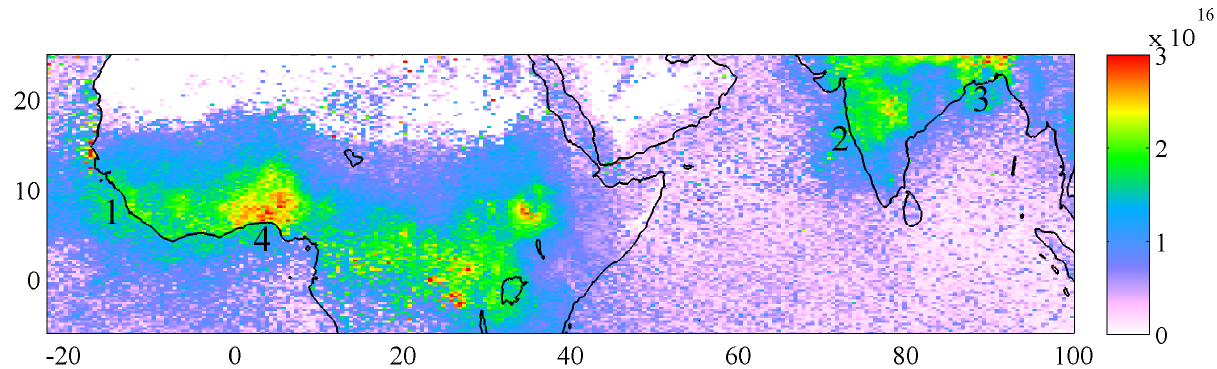
Fig. 12. NH 3 total columns (moleccm − 2 ) distribution averaged for February 2011. A post-filtering has been carried out excluding columns with a mean error above 100%. Transported NH 3 is observed mainly from fire plumes on the west and south coast of western Africa (1), and mainly from agricultural sources on the west coast of India (2), the Bay of Bengal (3) and the Gulf of Guinea